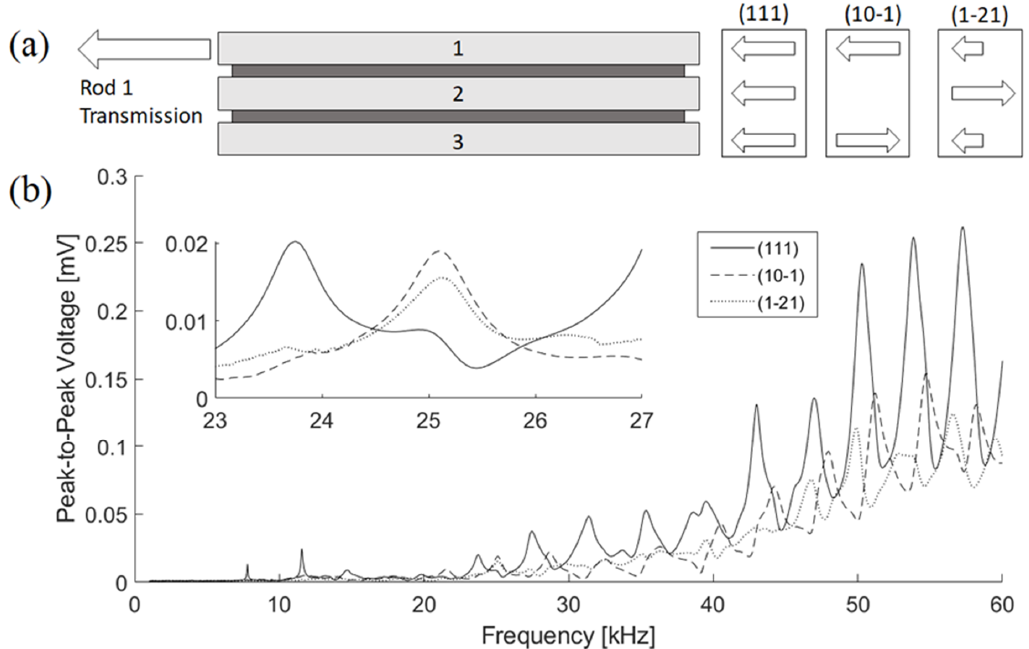
Figure 5. ( a ) Schematic of the approach used to measure the transmission spectrum for each OAM eigen vector. The three different driving forces are illustrated at the right of the array of waveguides. ( b ) Transmission spectrum of the three OAM modes reported as peak-to-peak voltage of the detecting transducer versus driving frequency. The driving frequency is varied between 0 and 60 kHz by increments of 200 Hz. Inset magnification of the transmission spectrum around 25.1